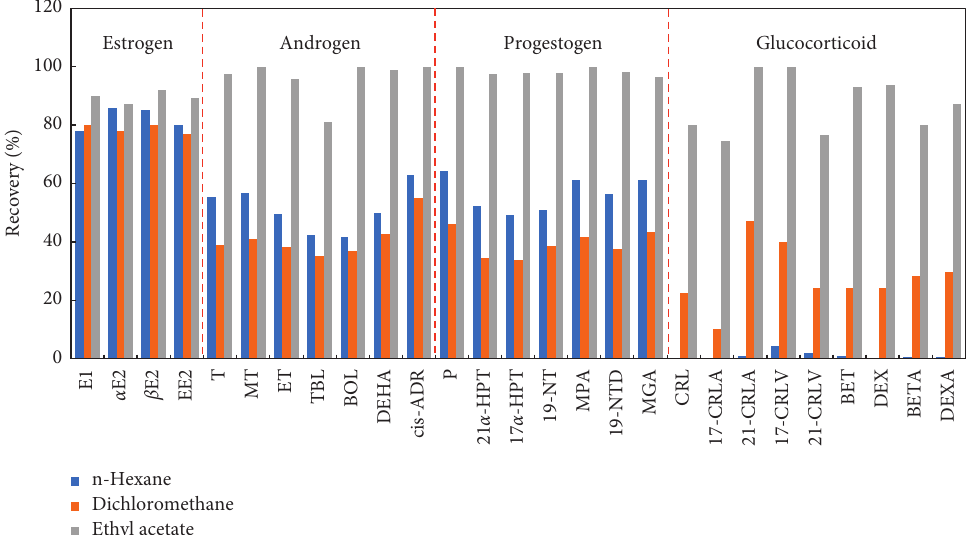
Figure 2: Recoveries (%) of target steroids with different elution